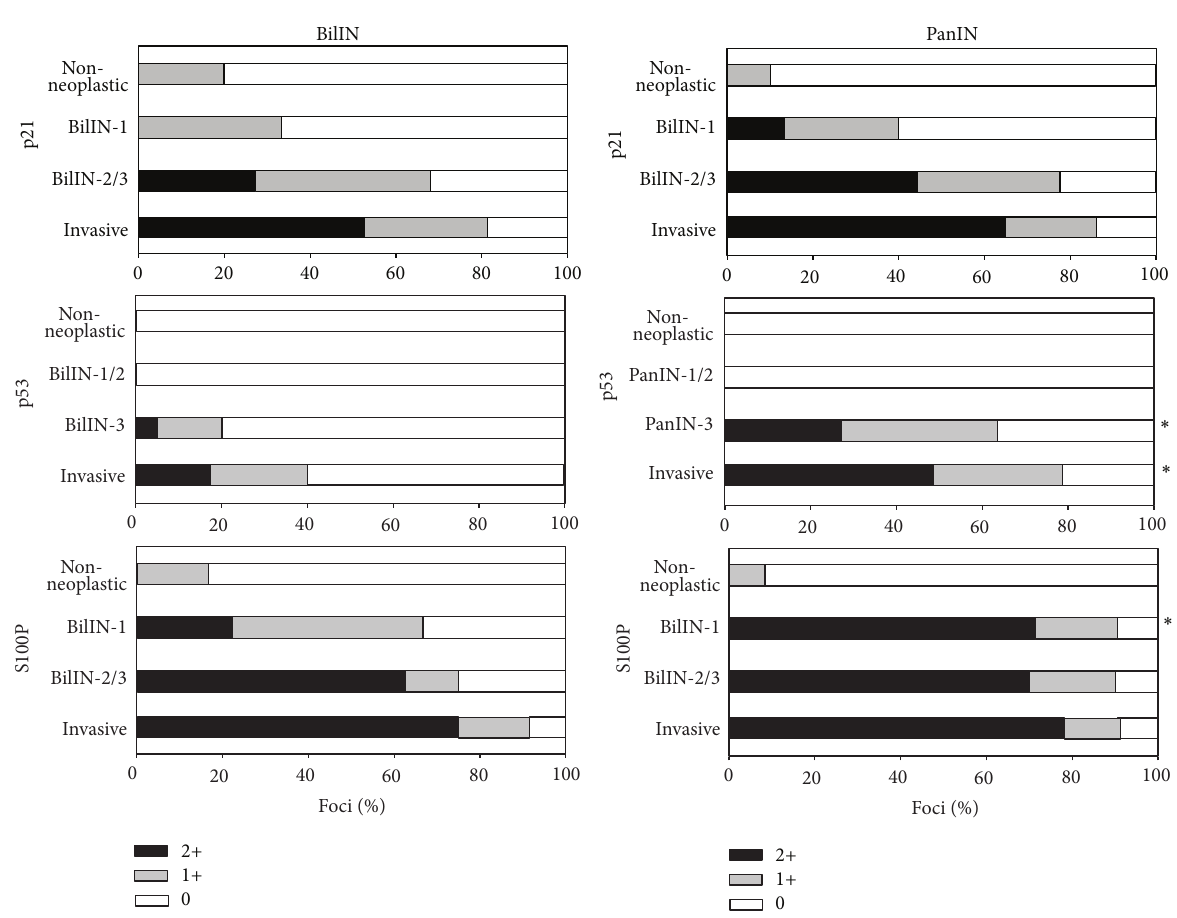
Figure 3: Semiquantitative analysis of the results of histochemical and immunohistochemical staining. The analysis was performed as described in Section 2 for the lesions of nonneoplastic epithelium of the bile ducts and the pancreatic ducts, biliary intraepithelial neoplasia (BilIN), pancreatic intraepithelial neoplasia (PanIN), and invasive carcinoma. ∗ 𝑃 < 0.05 versus the results of BilIN of corresponding histological grade or